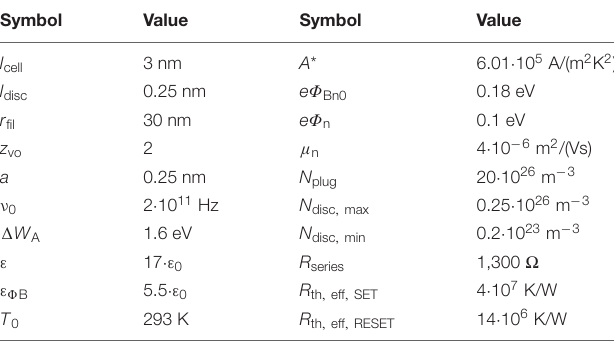
TABLE 1 | Simulation parameters (for the explanation of the symbols see Bengel et al., 2020).